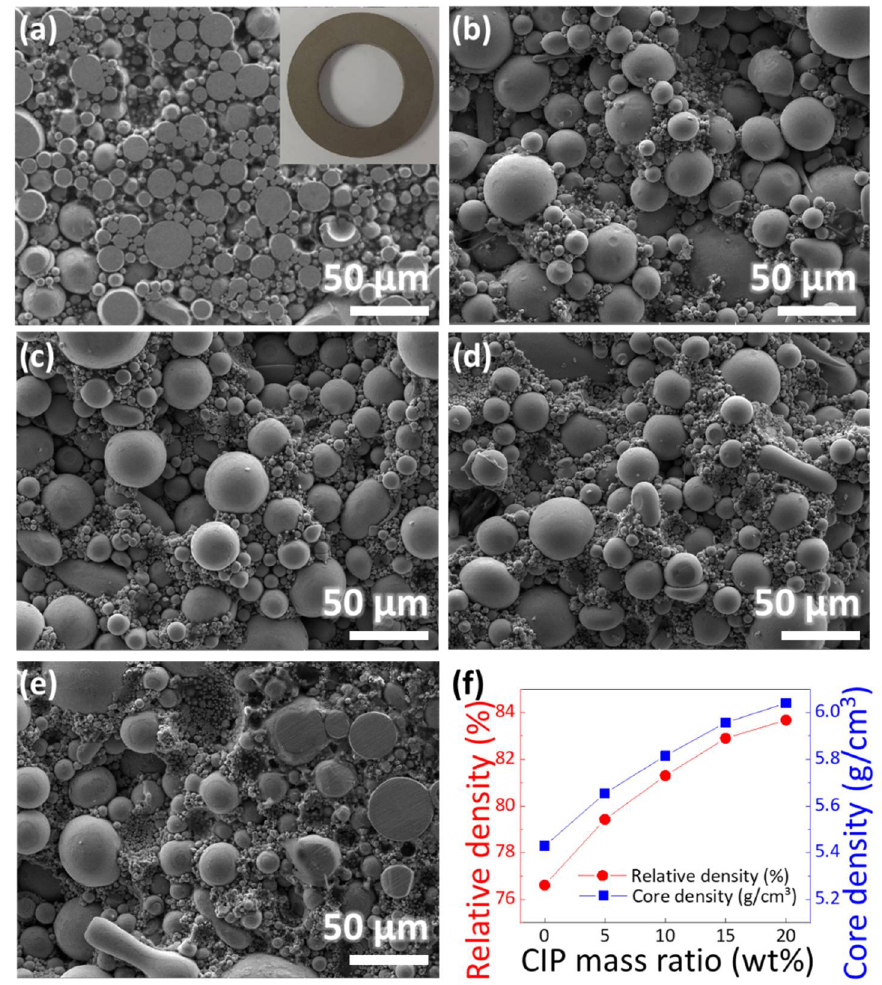
Figure 2. ( a – e ) SEM surface images of amorphous SMCs with ( a ) 0 wt.%, ( b ) 5 wt.%, ( c ) 10 wt.%, ( d ) 15 wt.%, and ( e ) 20 wt.% CIPs. Inset shows photograph of core sample. ( f ) Effects of CIP mass ratio on relative density and core density of amorphous SMCs with 0–20 wt.% CIP addition.